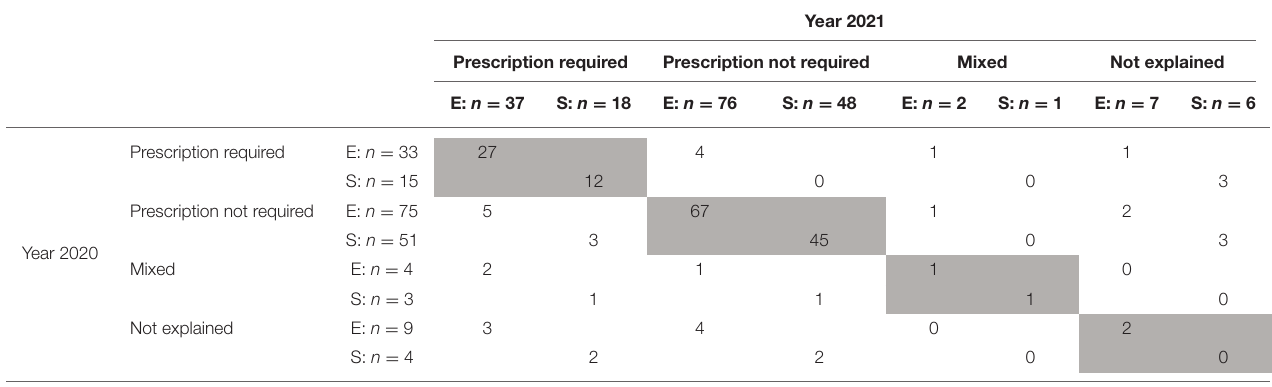
TABLE 2 | Changes in the requirement of prescription to purchase the antibiotics of the web pages analyzed in 2020 (2) and in 2021.